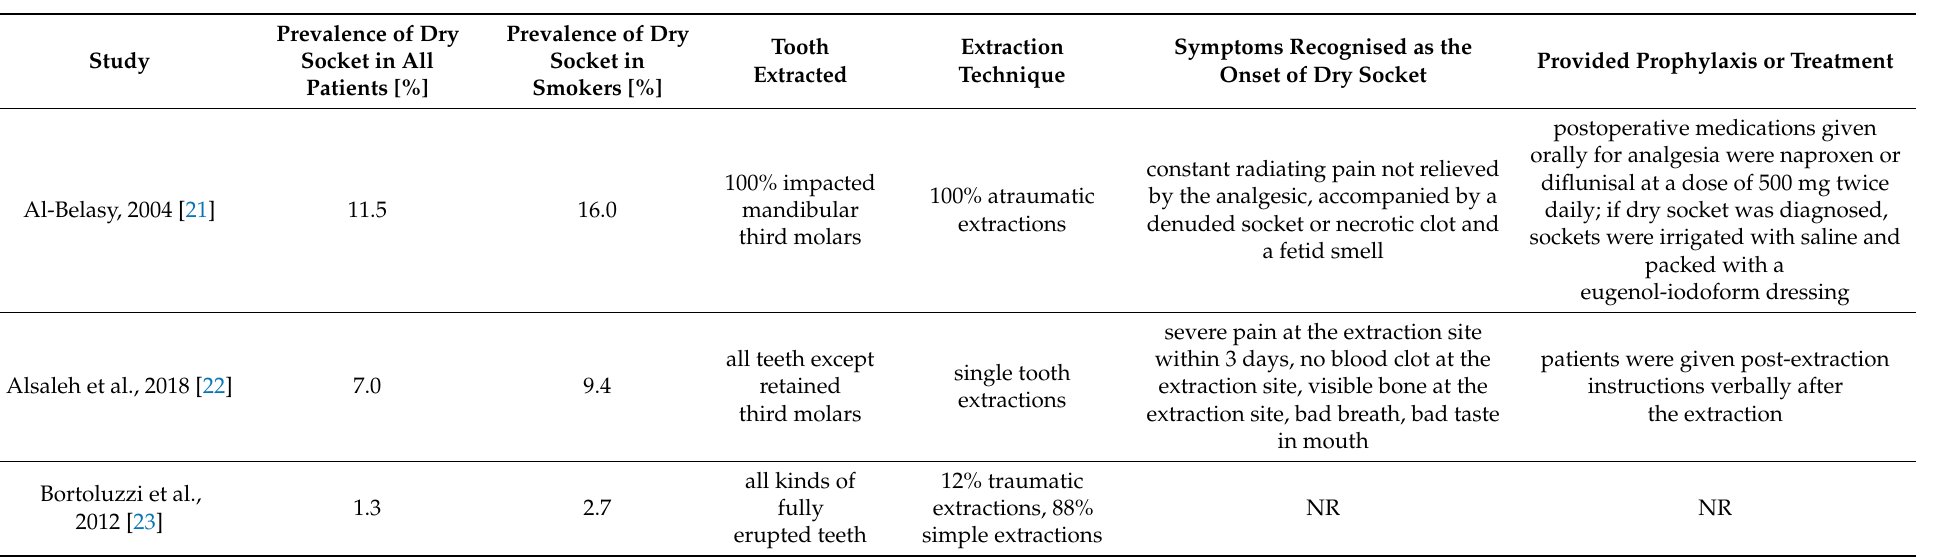
Table 3. Detailed characteristics of included studies considering prevalence of dry